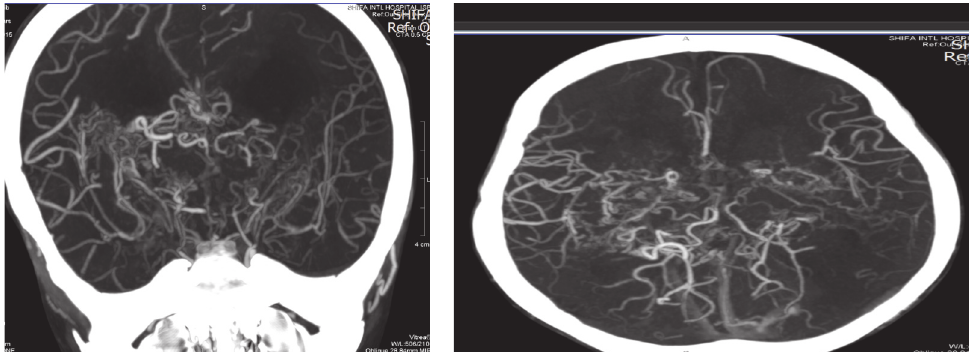
Figure 2: Postoperative CTA head showing good collateral supply to both cerebral